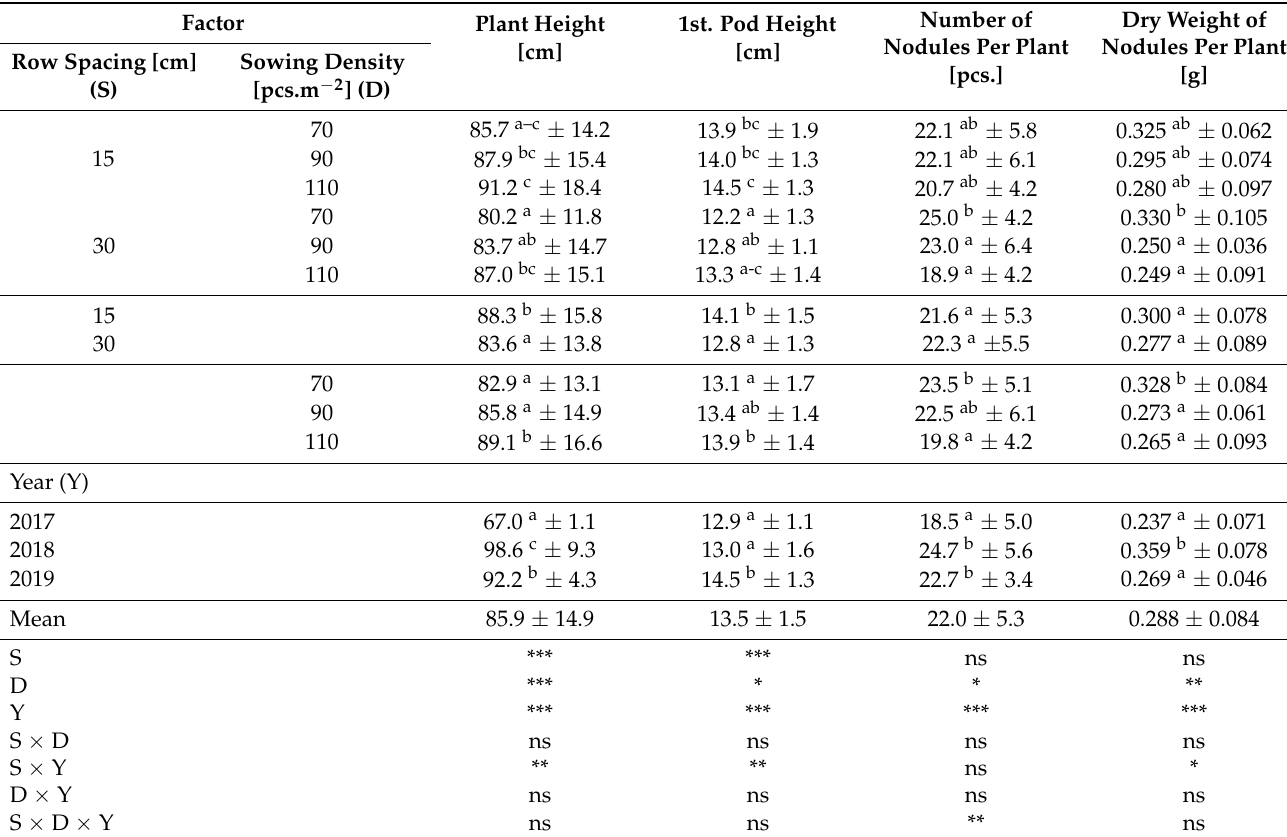
Dry Weight of Number of 1st. Pod Height Nodules Per Plant Nodules Per Plant [cm] [cm] [pcs.]